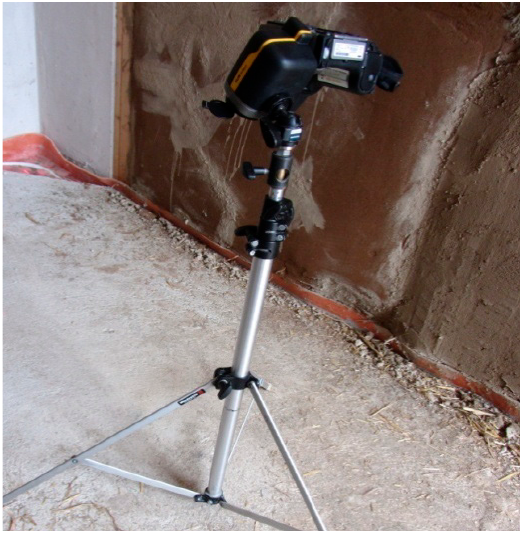
Figure 4. The infrared camera facing the radiant floor.